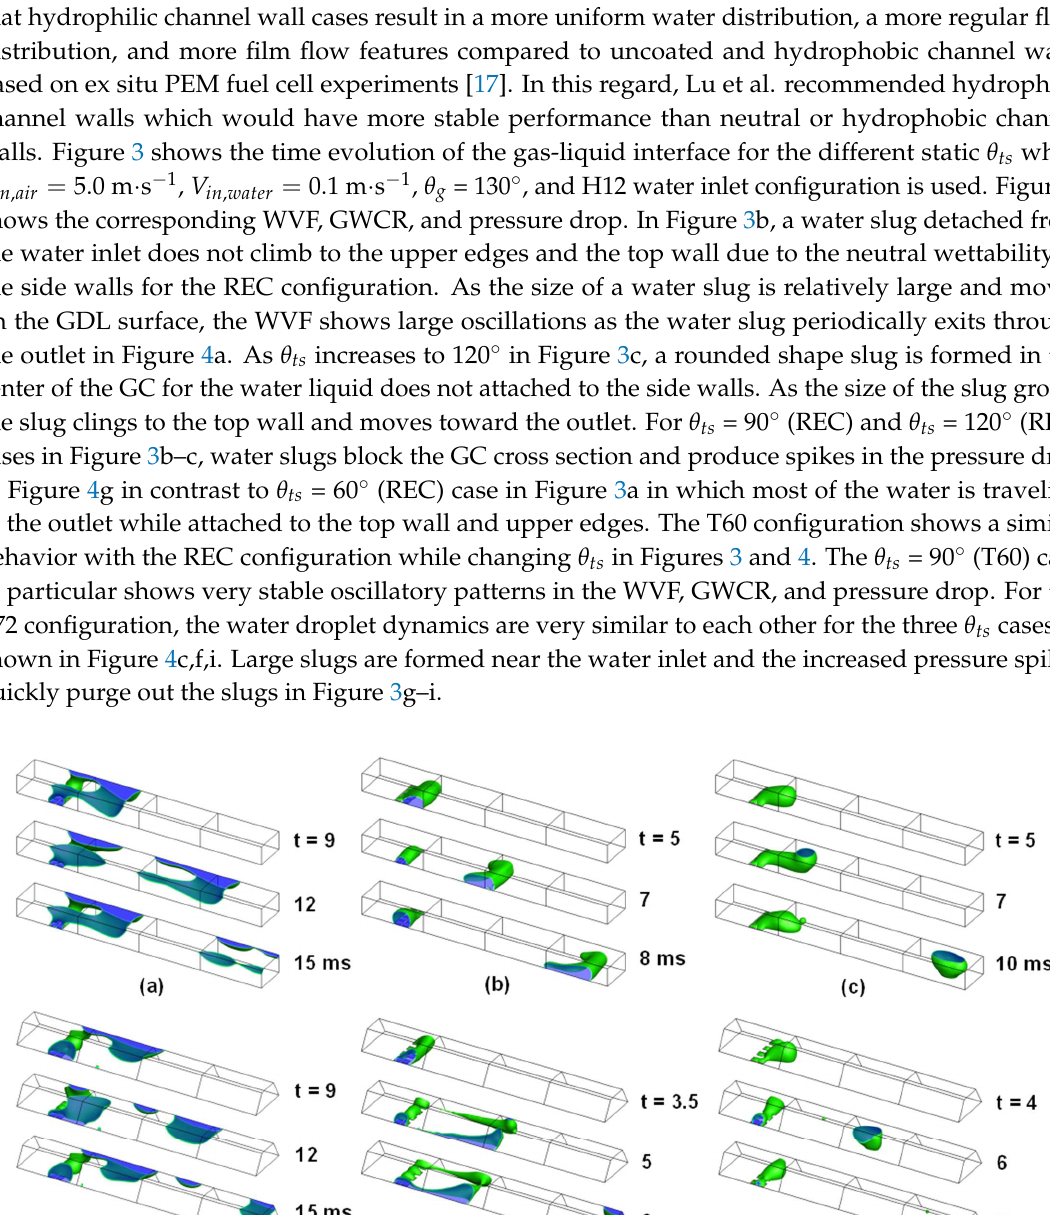
θ g = 130 ◦ , H12 water inlet configuration): ( a ) θ ts = 60 ◦ (REC); ( b ) θ ts = 90 ◦ (REC); ( c ) θ ts = 120 ◦